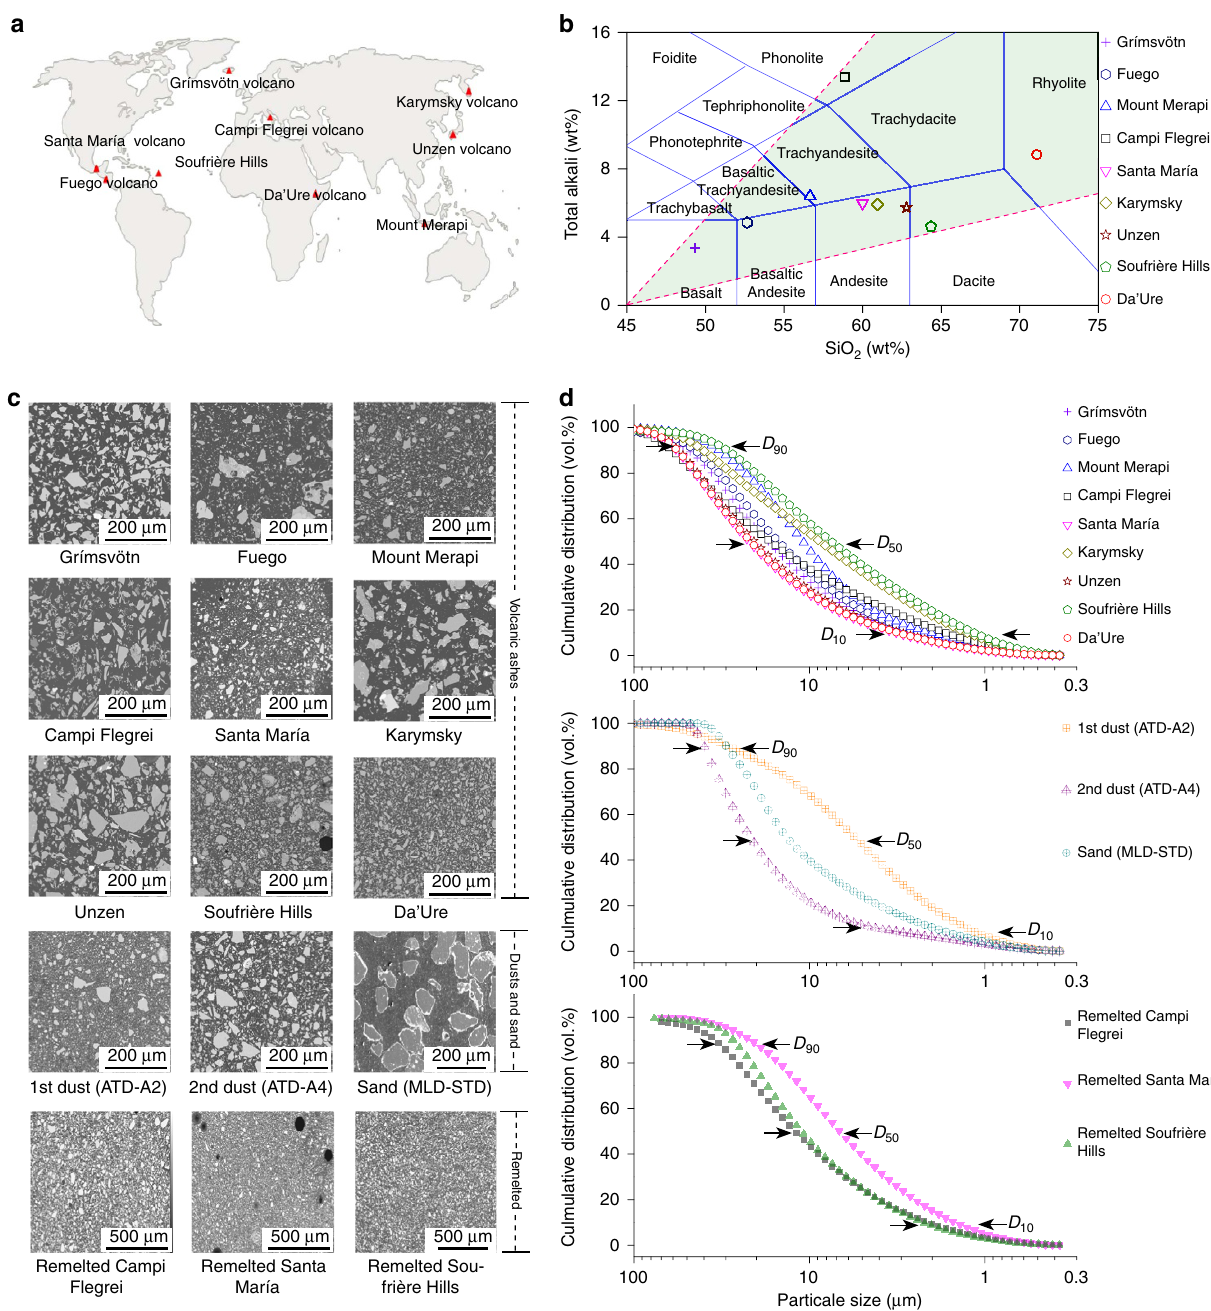
Figure 1 | Physical and chemical characteristics of the samples tested. ( a ) Volcanoes from which the volcanic ash samples were selected around the world. ( b ) Geochemical classification of the ash samples, showing that the tested chemistries span the range of magma composition of the most common volcanic eruptions. ( c ) Scanning electron microscope images of embedded starting material of each sample tested. ( d ) Cumulative volume distribution of the samples tested. The D 10 , D 50 and D 90 values constrain the smallest particle size, which contribute to define the coarsest 10, 50 and 90% particle fraction from the cumulative volume distribution,